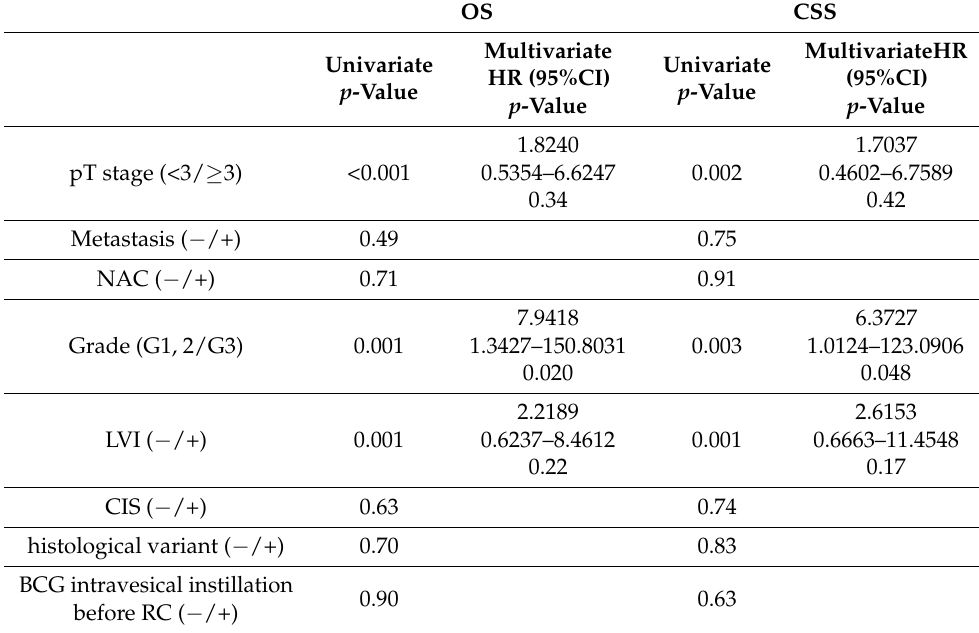
Table 3. Uni- and multivariate analyses of clinicopathological variables for OS and CSS after